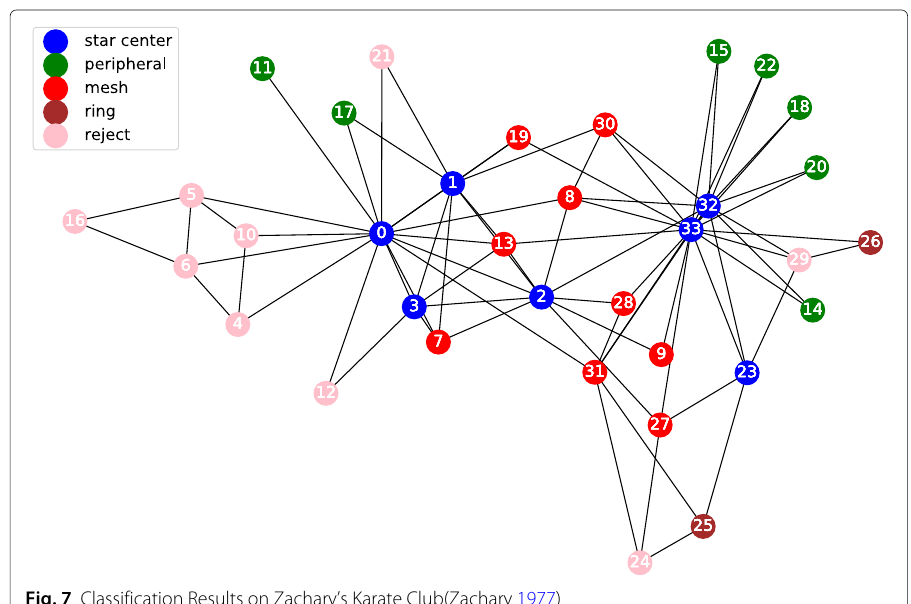
Fig. 7 Classification Results on Zachary’s Karate Club(Zachary 1977)